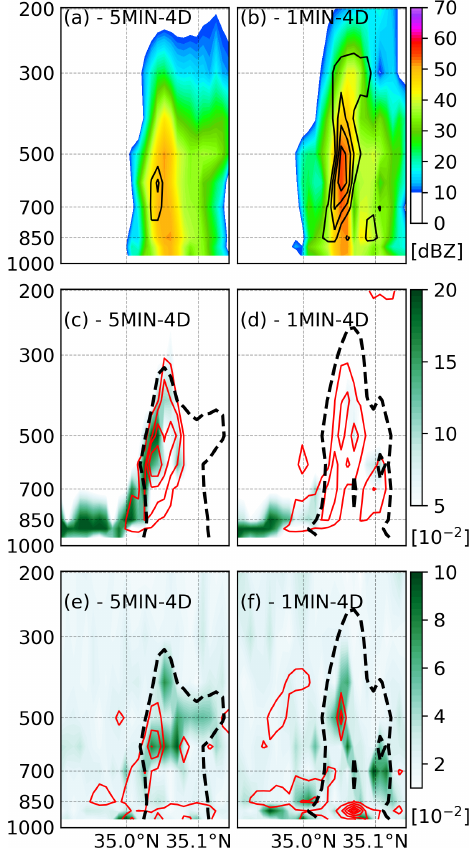
Figure 4. As in Fig. 2 but for (a, c, e) 5MIN-4D and (b, d, f) 1MIN-